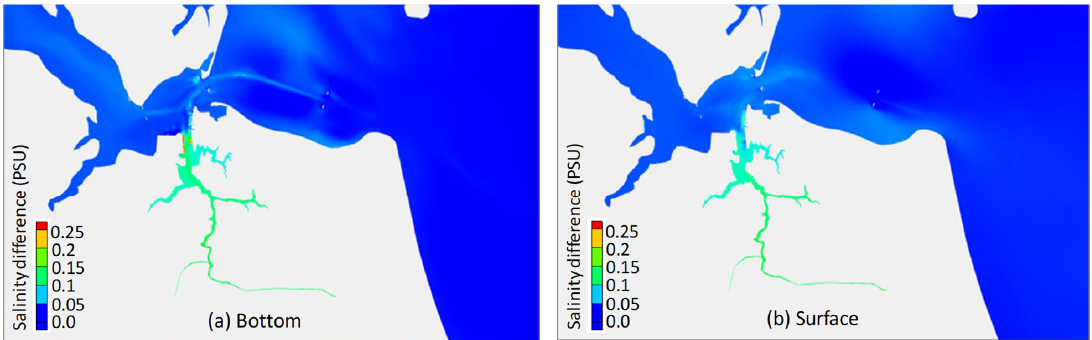
Figure 11. Plan view of the salinity difference (PSU; project scenario minus baseline, time-averaged in the simulation period): ( a ) bottom; ( b )